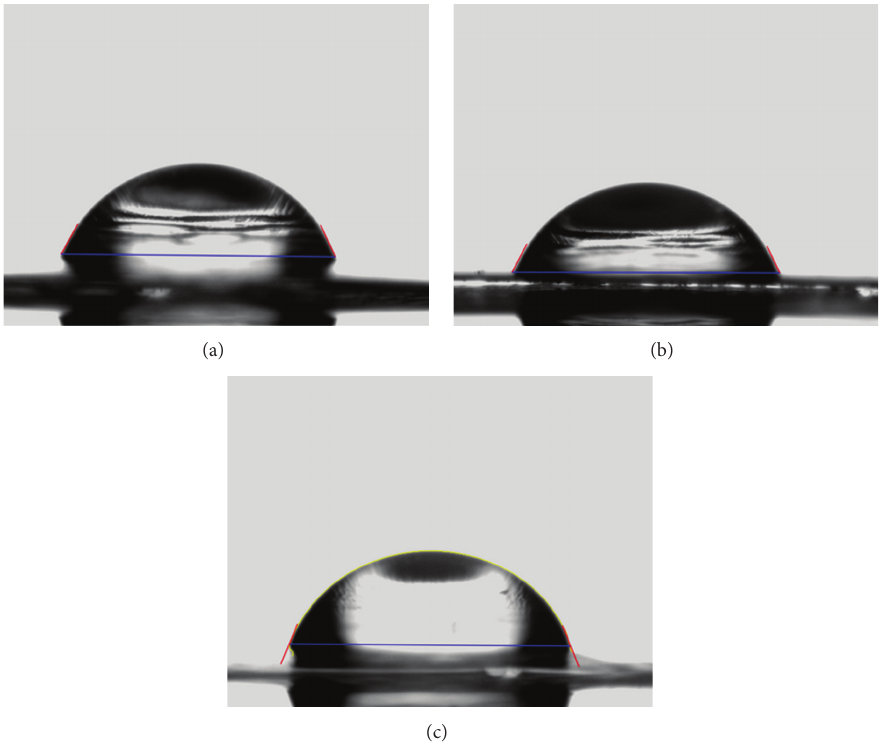
Figure 1: Contact angle of selected films ((a) C0.1T0; (b) C0.1T7; (c)